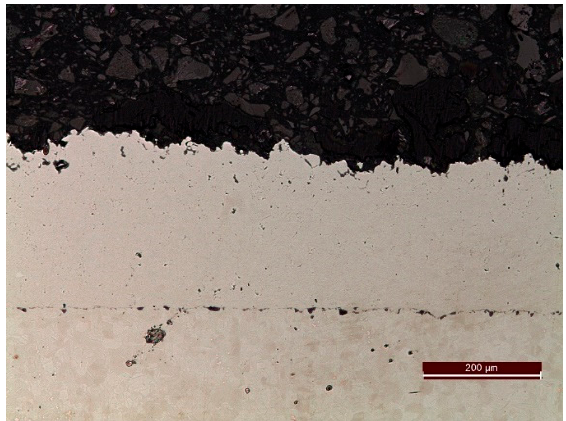
Figure 1. Coatings aspect after spray. The coating thickness resulted was uniform along all of the substrate surface. The correspondent etched microstructure is shown in Figure 2.